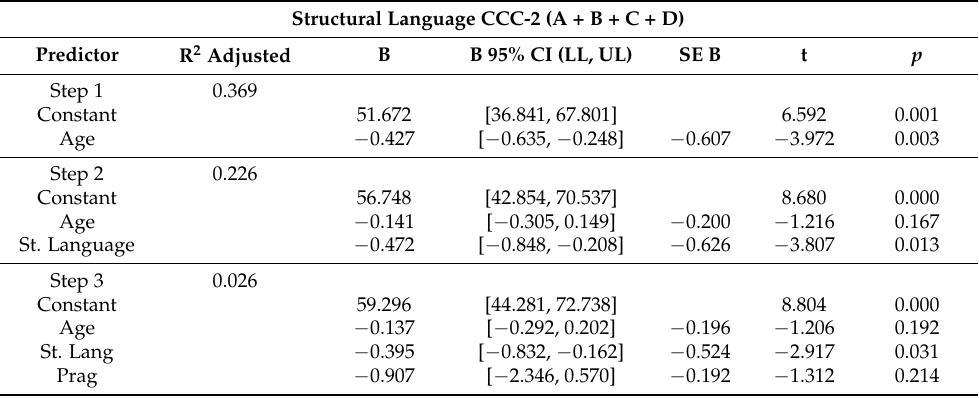
Table 5. Summary of regression coefficients for Structural Language CCC-2 scores (A + B + C + D) within the DLD group (bootstrap results based on 2000 bootstrap